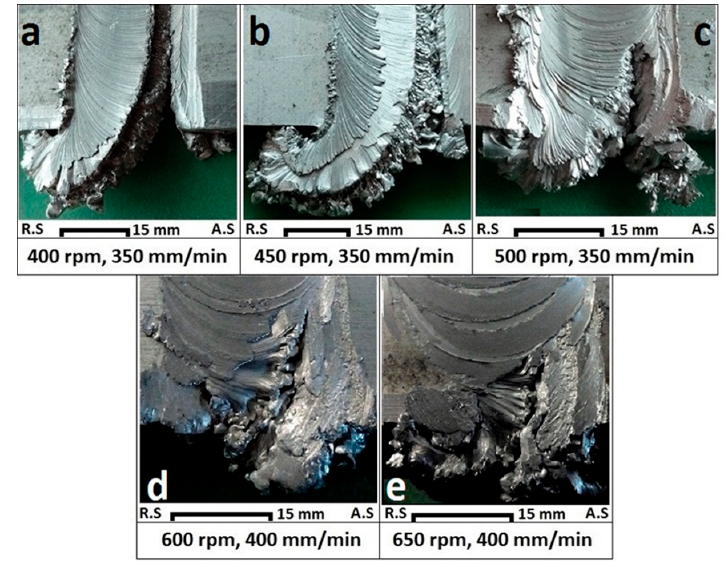
Figure 9. The entry region (Bottom view) for different ( ω / V ) ratios, ( a ) 400 rpm, 350 mm/min; ( b ) 450 rpm, 350 mm/min; ( c ) 500 rpm, 350 mm/min; ( d ) 600 rpm, 400 mm/min; and ( e ) 650 rpm, 400 mm/min.